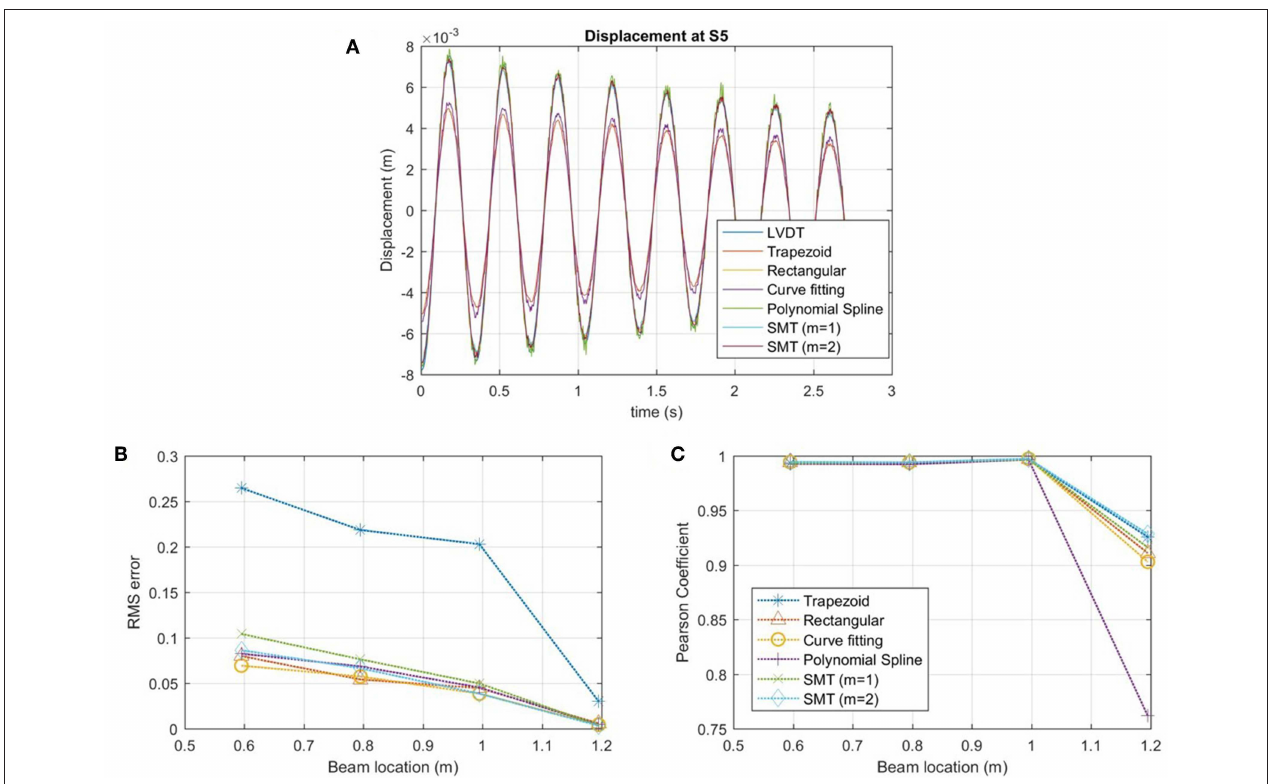
FIGURE 11 | Experimental free vibration tests on a cantilever beam, (A) displacement at sensor location S5 (1.2 meters), (B) RMS error, and (C) Pearson